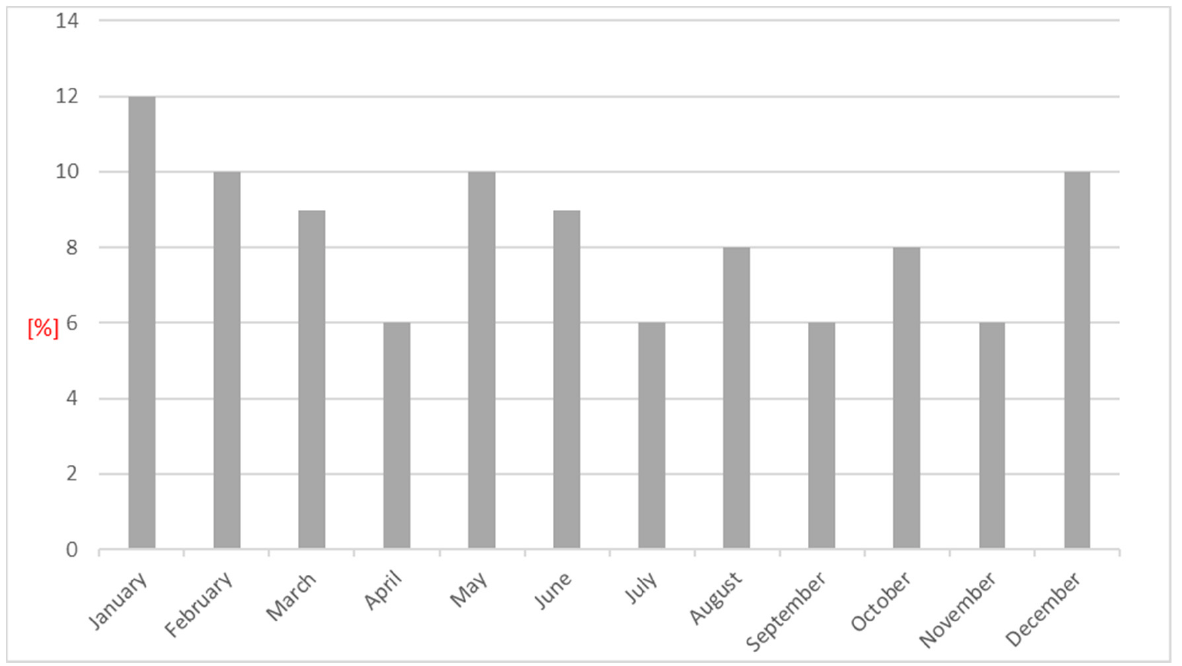
Figure 1. The percentage of patients hospitalized due to stroke by month.